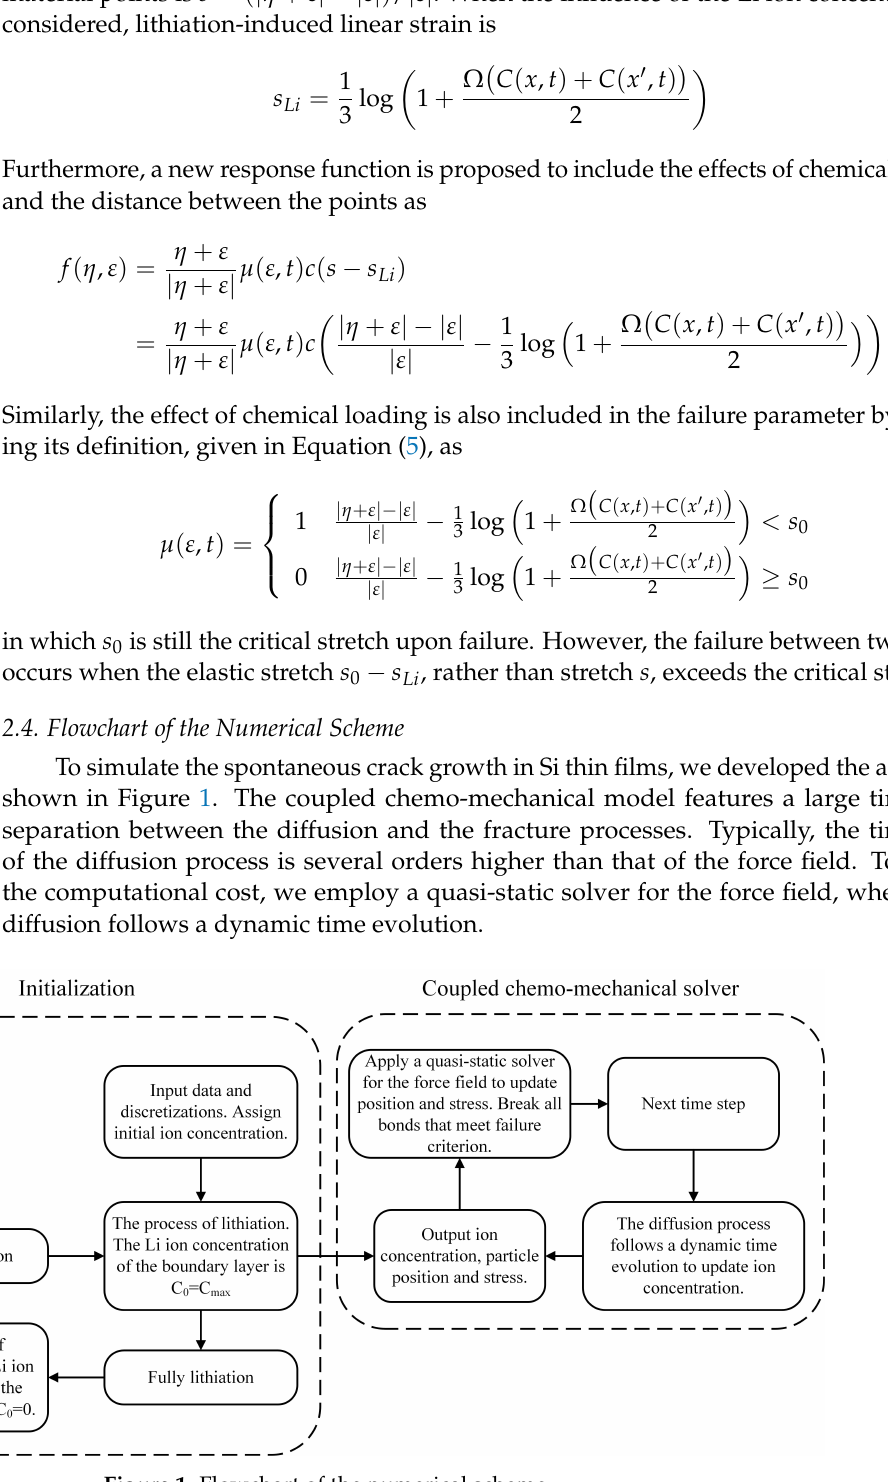
Figure 1. Flowchart of the numerical